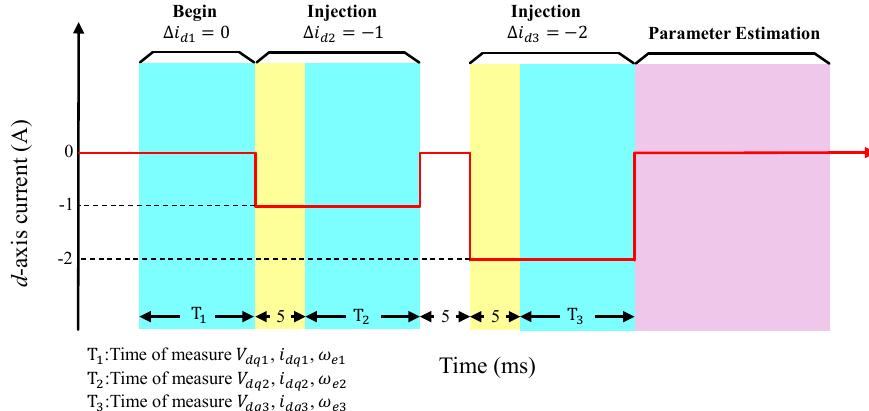
Figure 2. Implementation of the current injection method. The voltage model with d -axis current injection at steady state of an IPMSM in the